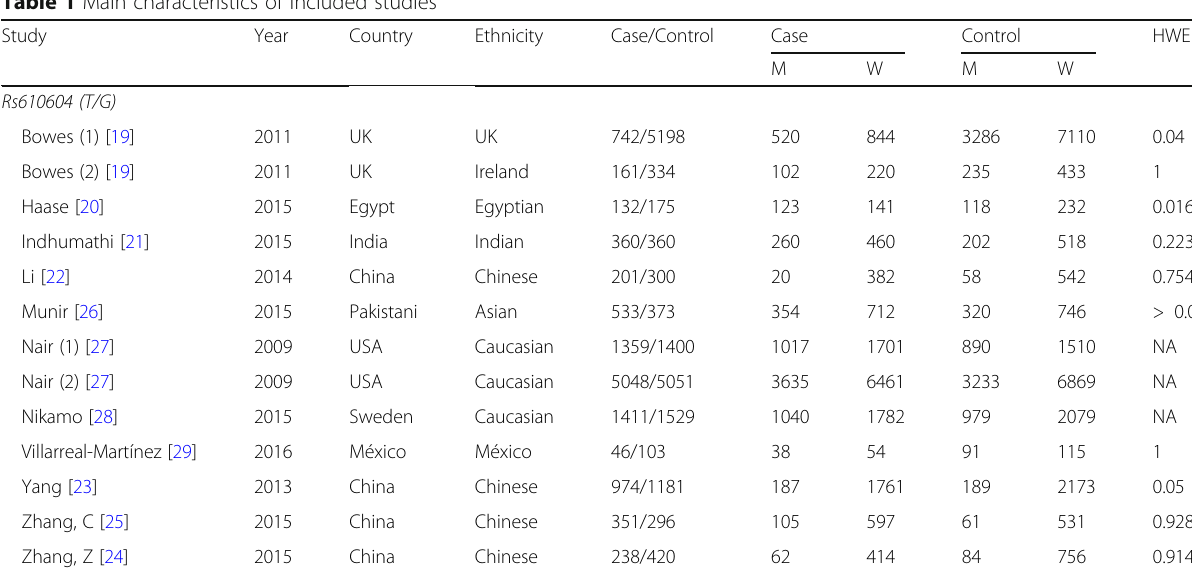
Fig. 2 Flow diagram of literature search and screen Table 1 Main characteristics of included